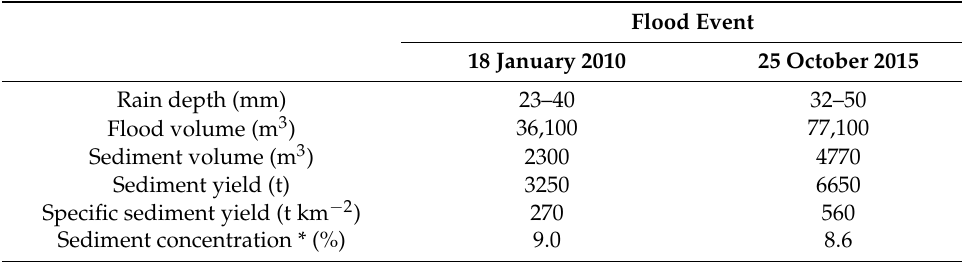
Table 1. Reservoir sedimentation and water input of two recent flood events. Sediment concentration was calculated as the mass ratio of event sediment/water using an undisturbed bulk sediment density of 1.4 t m − 3 .